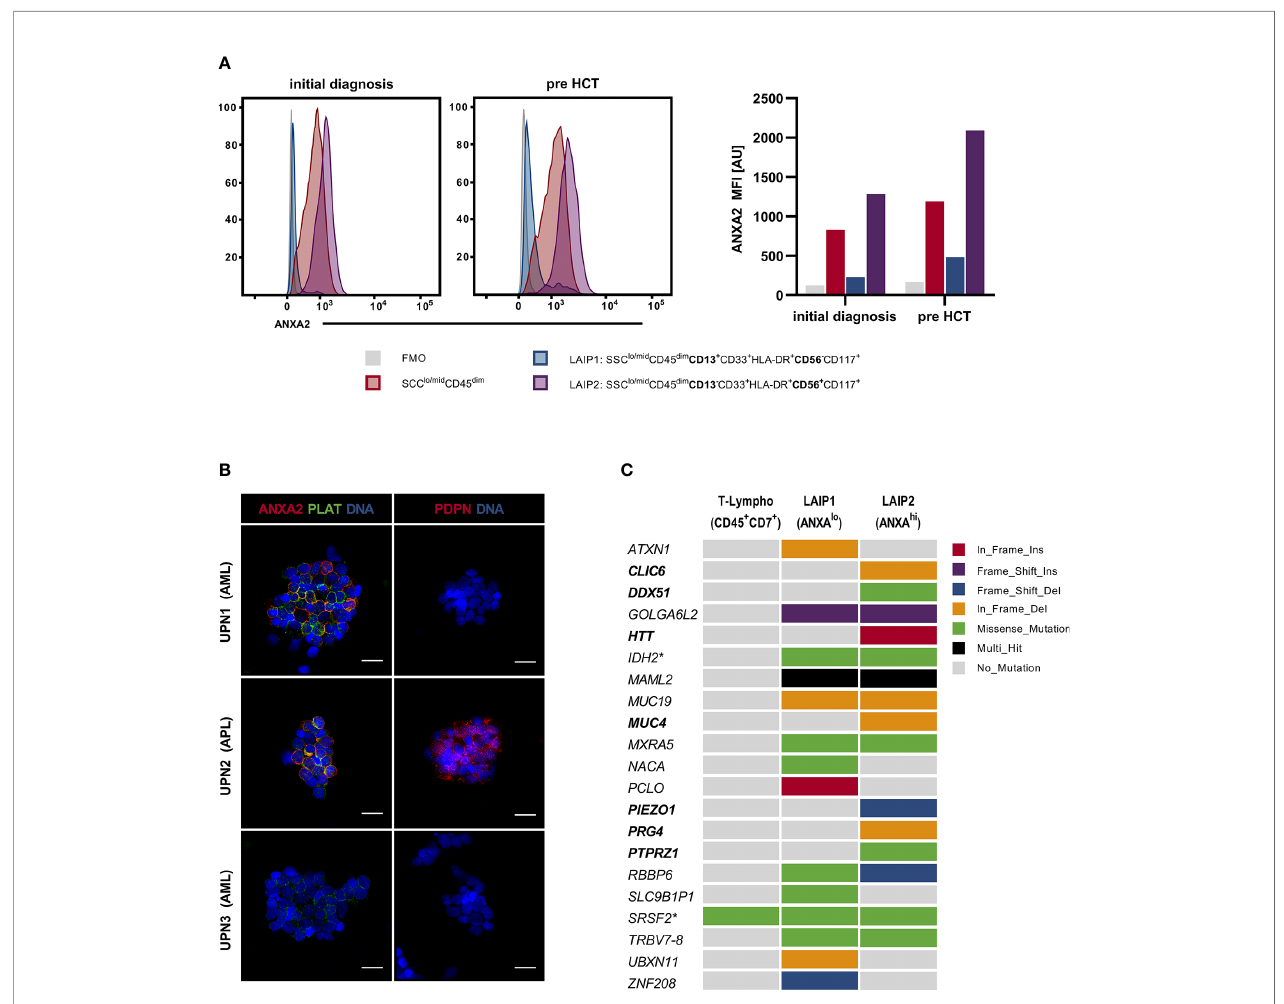
FIGURE 2 | Assessment of patients BM-MNCs via MFC, IF and WES. (A) Assessment of ANXA2 in UPN1 BM-MNCs populations via MFC: BM-MNCs (SSC lo/mid CD45 dim ) [red] showed distinct ANXA2 expression on initial presentation as well as pre alloHCT. On closer examination, 2 LAIP were identi fi ed: LAIP1 (SSC lo/mid CD45 dim CD13 + CD33 + HLA-DR + CD56 - CD117 + ) [blue] showed nearly no ANXA2 expression, whereas LAIP2 (SSC lo/mid CD45 dim CD13 - CD33 + HLA- DR + CD56 + CD117 + ) showed excessive ANXA2 expression [purple]. FMO: negative control [grey]. (B) Assessment of ANXA2, PLAT and PDPN via IF: BM-MNCs from UPN1 showed marked ANXA2 and PLAT expression, whereas no PDPN expression was observed. BM-MNCs from UPN2 (a patient diagnosed with APL) expressed ANXA2, PLAT as well as PDPN, whereas BM-MNCs from UPN3 (a patient diagnosed with AML (FAB M2) with KMT2A- PTD and an IDH2 mutation without evidence of DIC) neither showed ANXA2 nor PDPN expression, only low-level PLAT expression was observed. Scale bar corresponds to 20µm. (C) Mutational pro fi le of LAIP 1 (MFC ANXA2 lo ) and LAIP2 (MFC ANXA2 hi ) as assessed by WES; T-lymphocytes served as a germline-like control. Columns represent LAIPs, rows represent genes and box color indicates the type of genomic alteration. Variants in bold print are exclusively found in LAIP2. Asterisk indicates previously known variants in IDH2 and SRSF2 . alloHCT, allogeneic hematopoietic cell transplantation; ANXA2, annexin A2; AU, arbitrary units; BM-MNCs, bone marrow derived mononucleated cells; DIC, disseminated intravascular coagulation; FMO, fl uorescence minus-one; LAIP, leukemia-associated immunophenotype; MFC, multiparametric fl ow cytometry; PLAT, tissue-type plasminogen activator; PDPN, podoplanin; UPN, unique patient number; WES, whole-exome